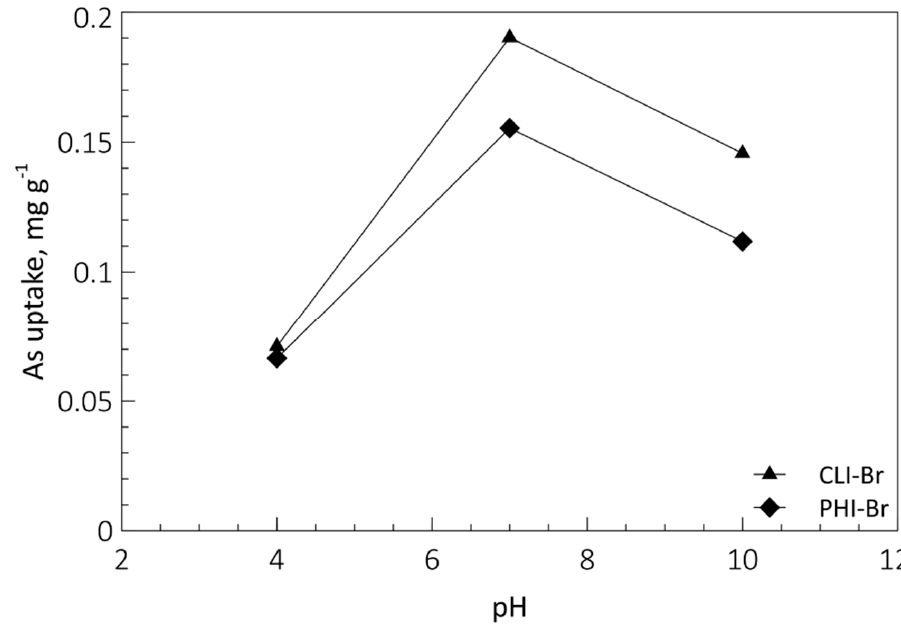
Figure 3. E ff ect of pH on the As(V) uptake in CLI-Br and PHI-Br at T = 25 ◦ Figure 3 . Effect of pH on the As(V) uptake in CLI-Br and PHI-Br at T = 25 °C.